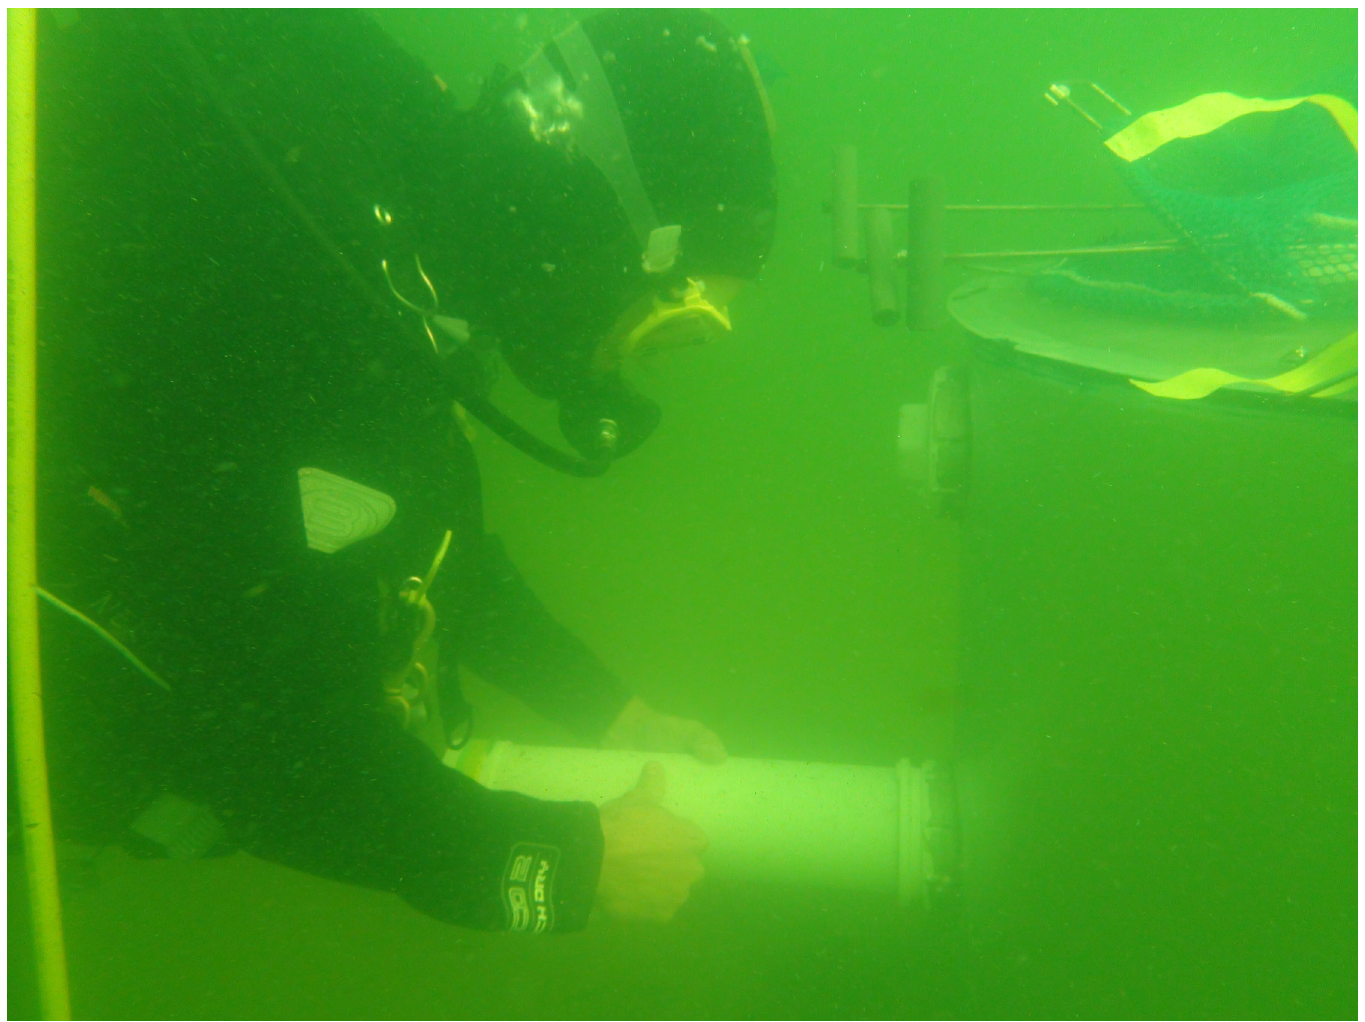
Fig 2. Picture taken on the first day of the experiment, just after the insertion of a benthocosm in the sediment, showing a diver sampling for nutrients and plankton. Photo courtesy of Simon